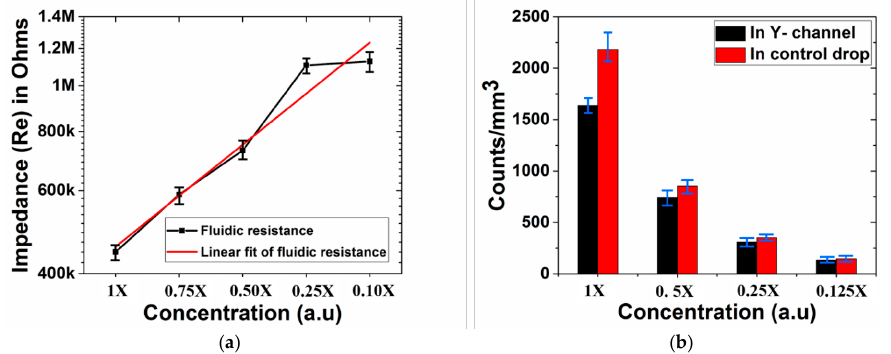
Figure 19. ( a ) Fluidic resistance in the Y-channel for varying concentrations of Dulbecco’s phosphate buffered saline (PBS) buffer with a linear fit of the fluidic resistance for n = 3 devices; ( b ) optical counting of the beads for different concentrations of the PS beads in the junction of the Y-channel compared to a polystyrene petri dish ( n = 3 for both the microfluidic chip and the petri dish control devices).